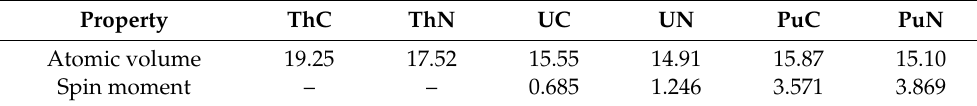
Table 3. Atomic volumes (Å 3 /atom) and spin moments ( µ B ) from VASP-PAW calculations. Property ThC ThN UC UN PuC PuN Atomic volume 19.25 17.52 15.55 14.91 15.87 15.10 Spin moment – – 0.685 1.246 3.571